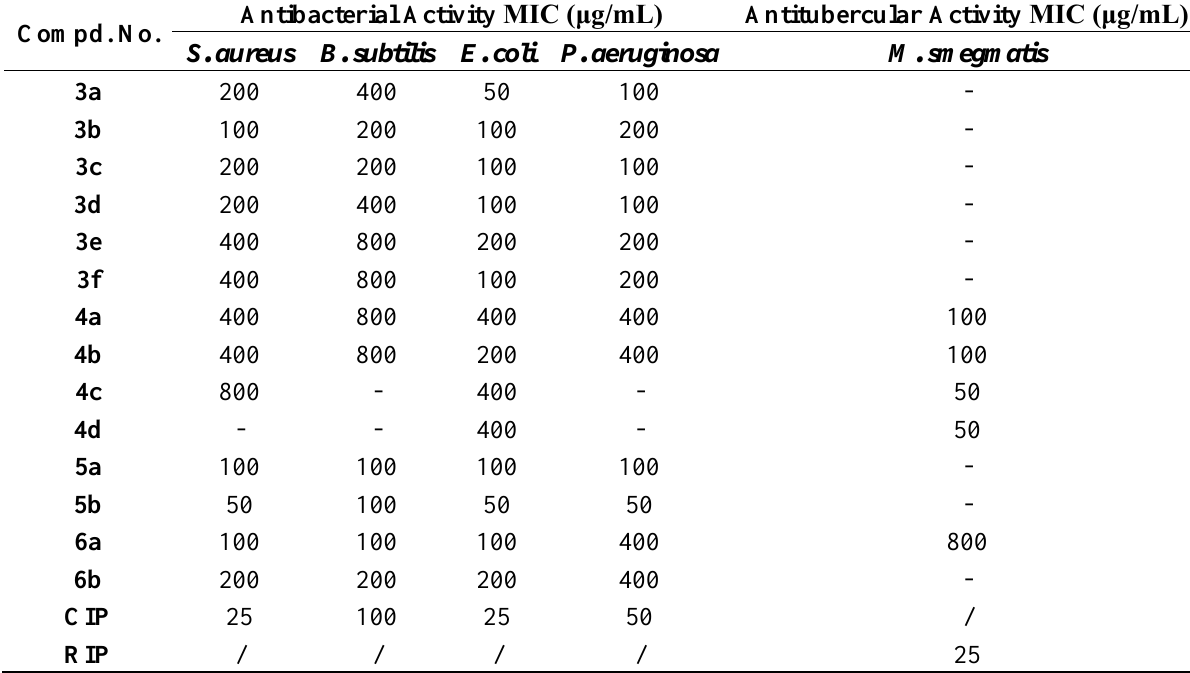
Table 1. In vitro antibacterial and antitubercular